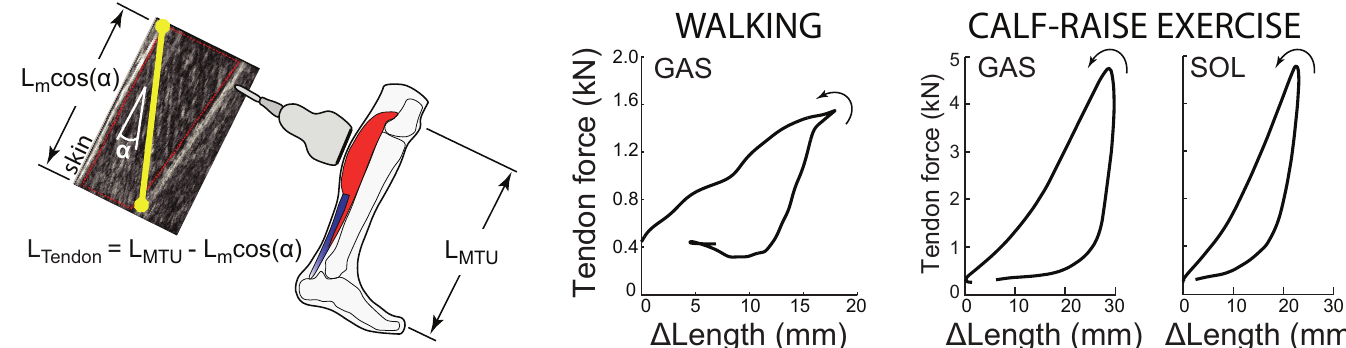
Fig 1. Indirect tendon estimation method and tendon work loops. Left: A common method for estimating changes in tendonlength, L Tendon , which we term Indirect, is to subtract ultrasound-based estimates of longitudinalmuscle length change, L m cos α ,from overallMTU length, L MTU . With this method the ultrasoundtransducer is positioned over the muscle belly. Right: Indirect tendon kinematics can then be combinedwith tendonforce estimates to examine tendon work loops. Walkingdata shown here are from [19], and calf-raise data are from [24] (see Methods for details on how data were digitized).Empirical evidencefrom walking( N = 8) [19] and from isolatedcalf-raise exercises( N = 7) [24] indicatesthat this Indirect method results in substantialpositive work loops (i.e., net positive work performed by tendon, with 2–5 J of elastic energyreturnedfor each 1 J stored), which is implausible for passive tendinous